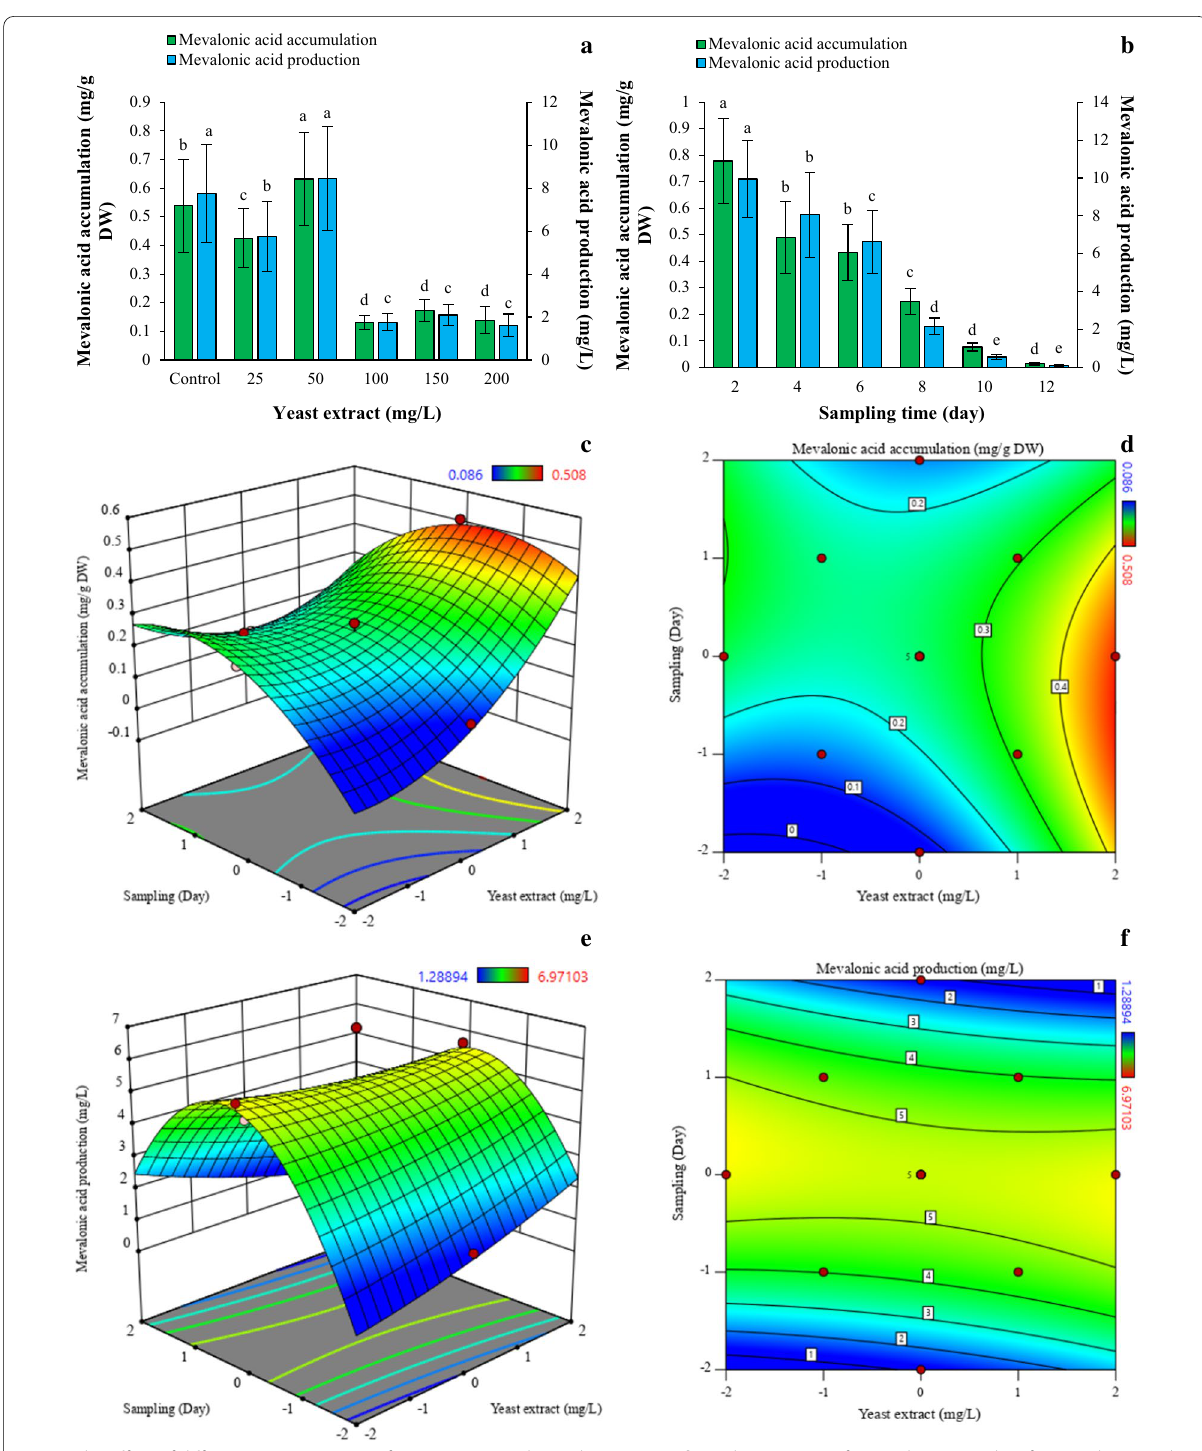
Fig. 3 The effect of different concentrations of yeast extract and sampling times ( a , b ) and response surface and contour plots for mevalonic acid accumulation ( c , d ) and mevalonic acid production ( e , f